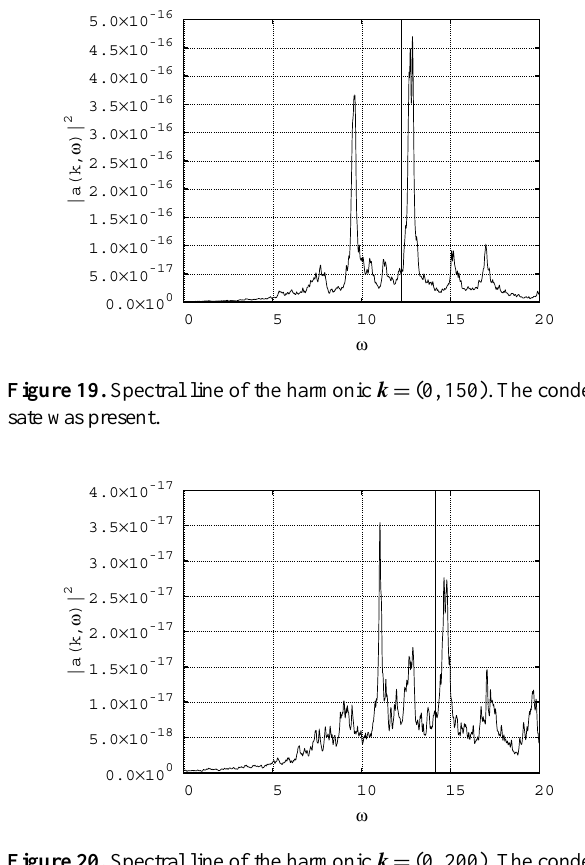
Figure 18. Spectral line of the harmonic k = (0, 100). The conden- sate was present.